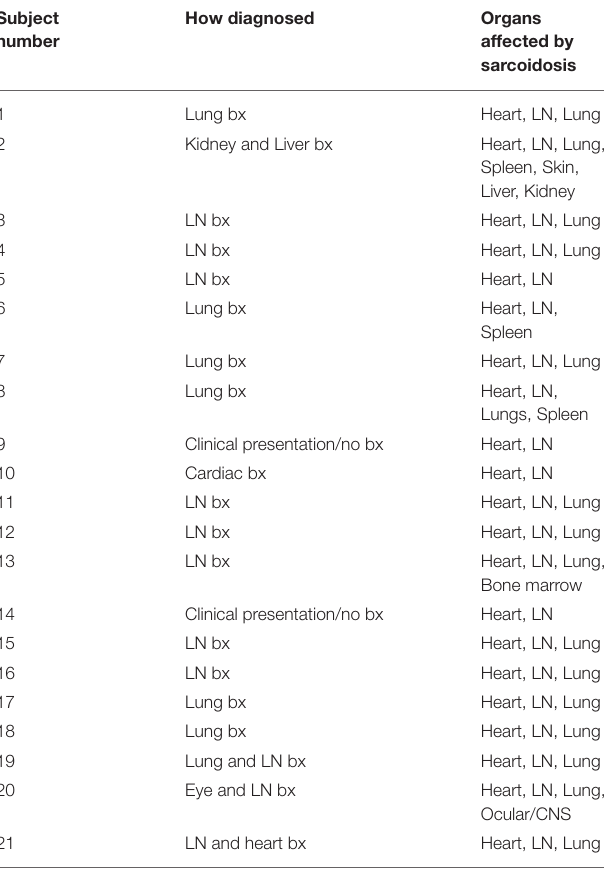
TABLE 2 | Sarcoidosis details of patients with recurrently active cardiac